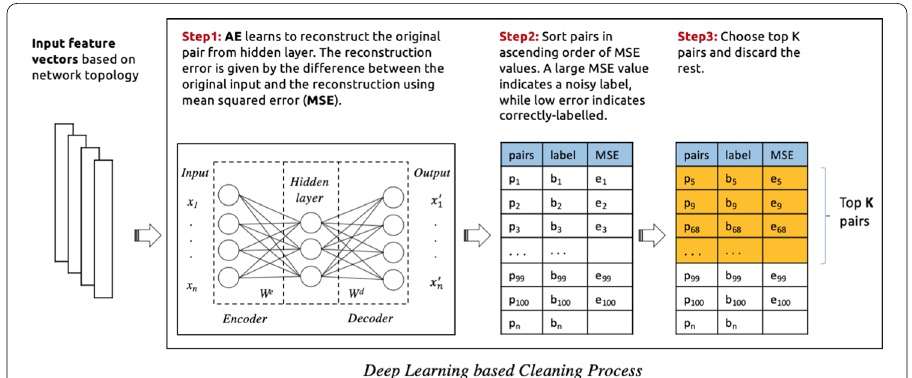
Fig. 5 An illustration of the process for identifying noisy pairwise constraints using deep learning approach (neural network autoencoder (AE))